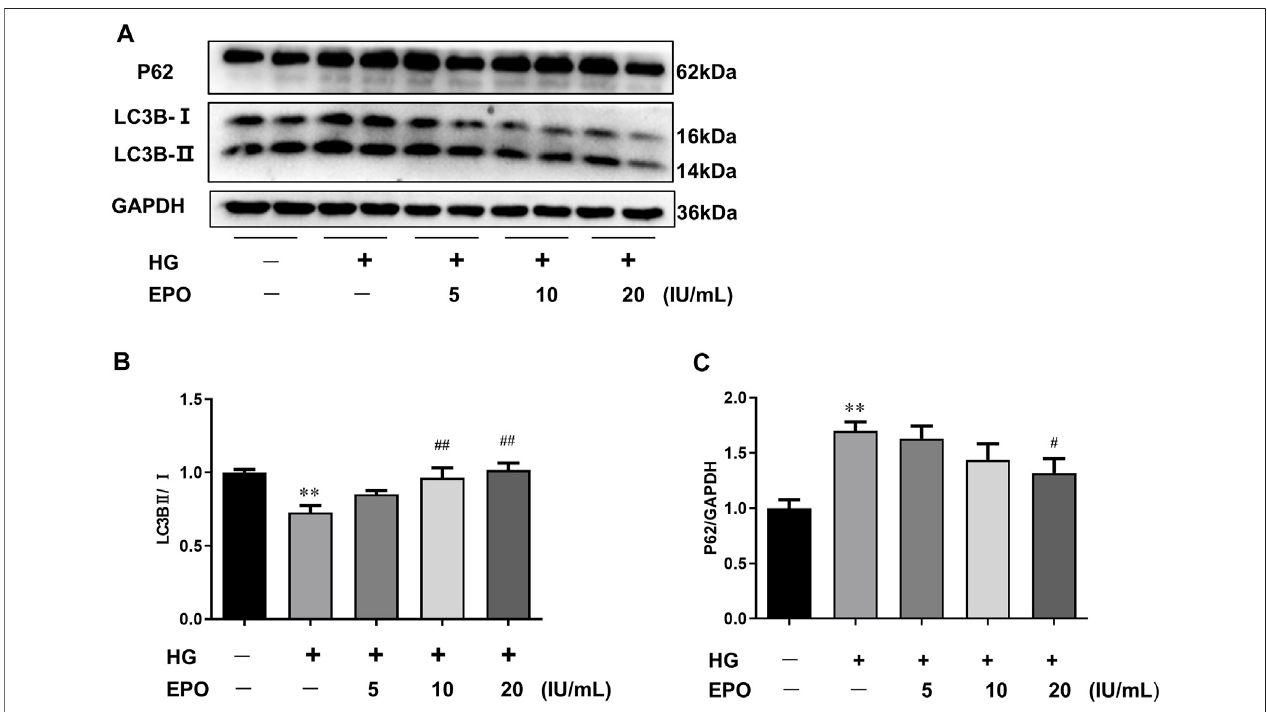
FIGURE1 | EPO reversed HG-induced the blockage ofautophagic fl ux inmesangial cells. (A) Representative immunoblotsand quanti fi cation of (B) LC3B and (C) P62. Values are presented as mean ± SEM, n = 3. ** p < 0.01 vs. Control group; # p < 0.05, ## p < 0.01 vs. HG